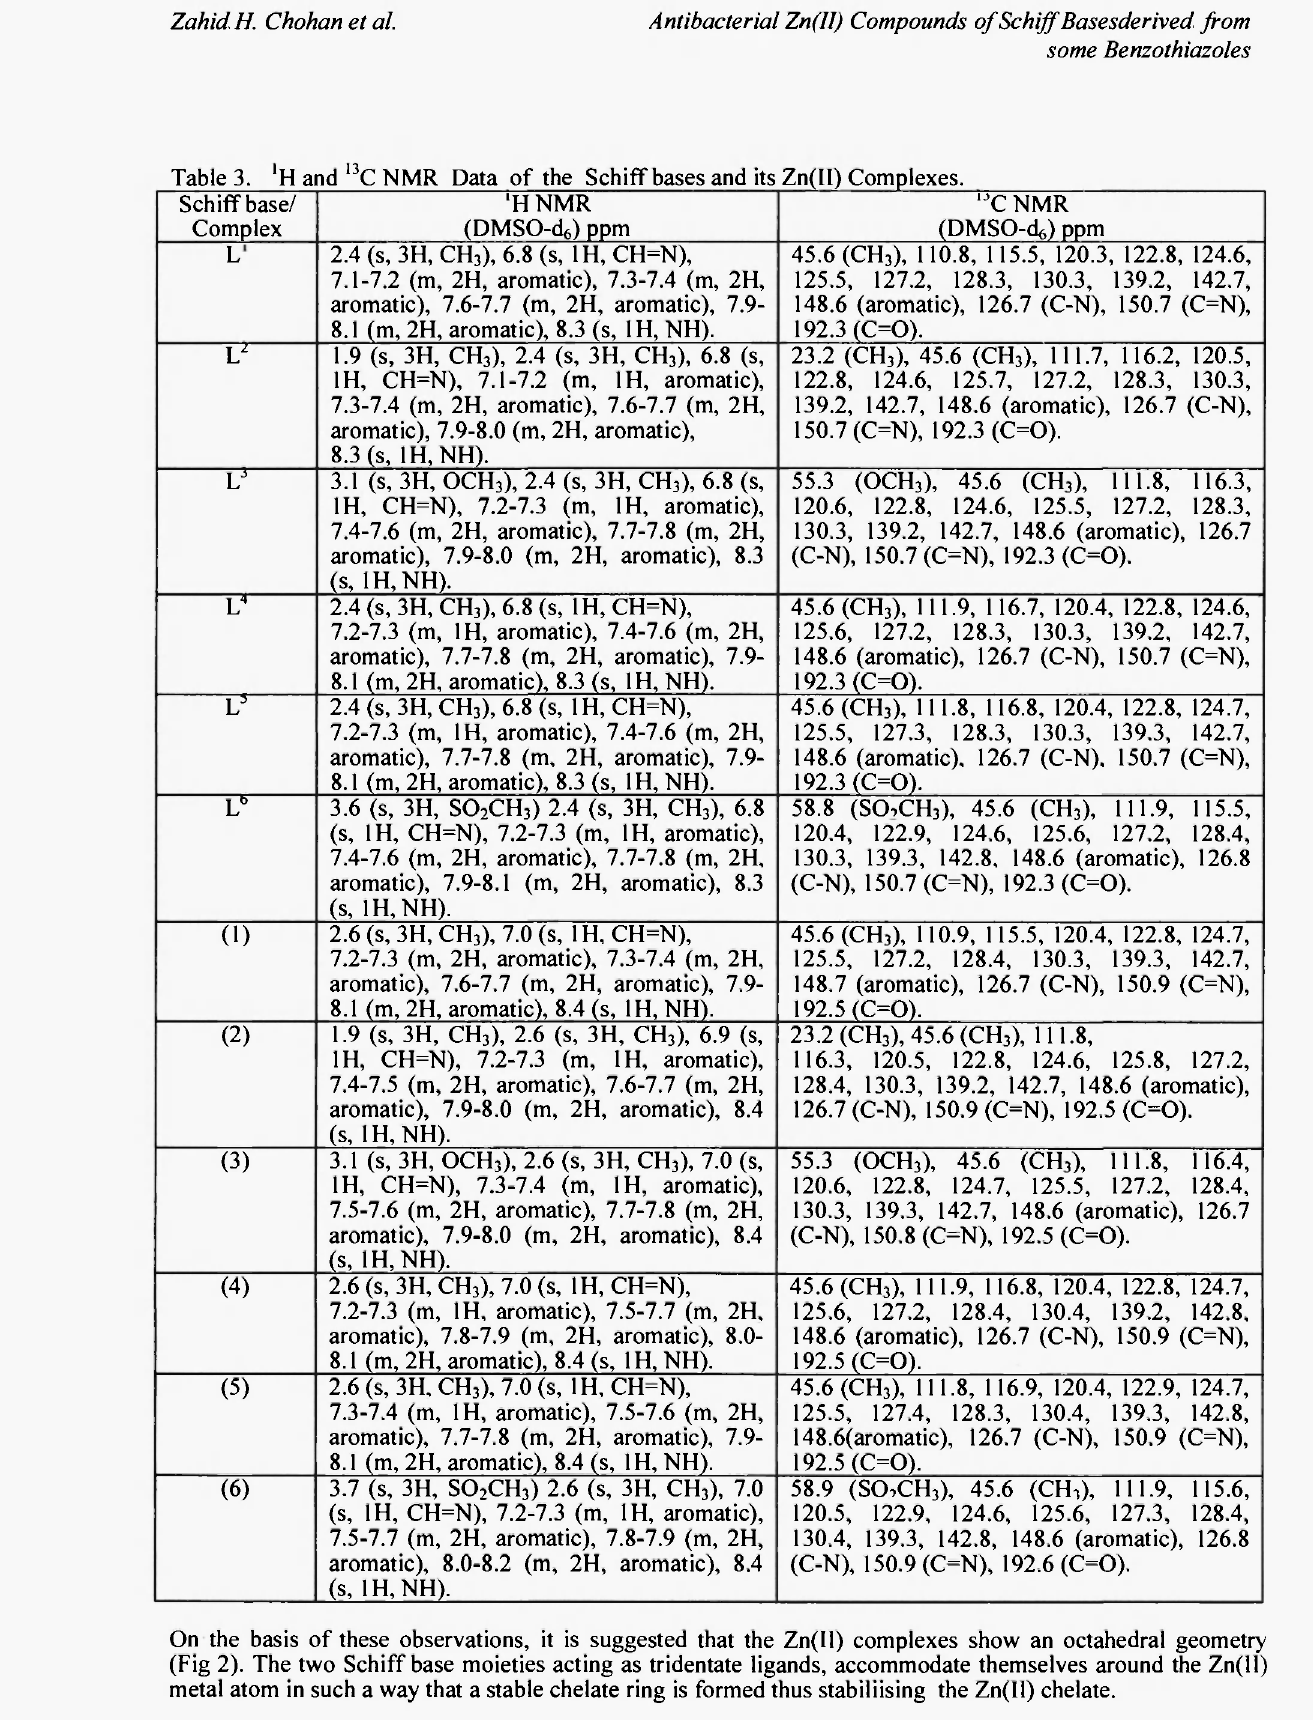
Table 3. 'H and 13 C NMR Data of the Schiff bases and its Zn(II) Complexes. Schiff base/